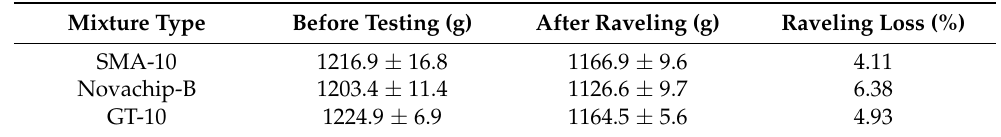
Table 5. Cantabro test results.